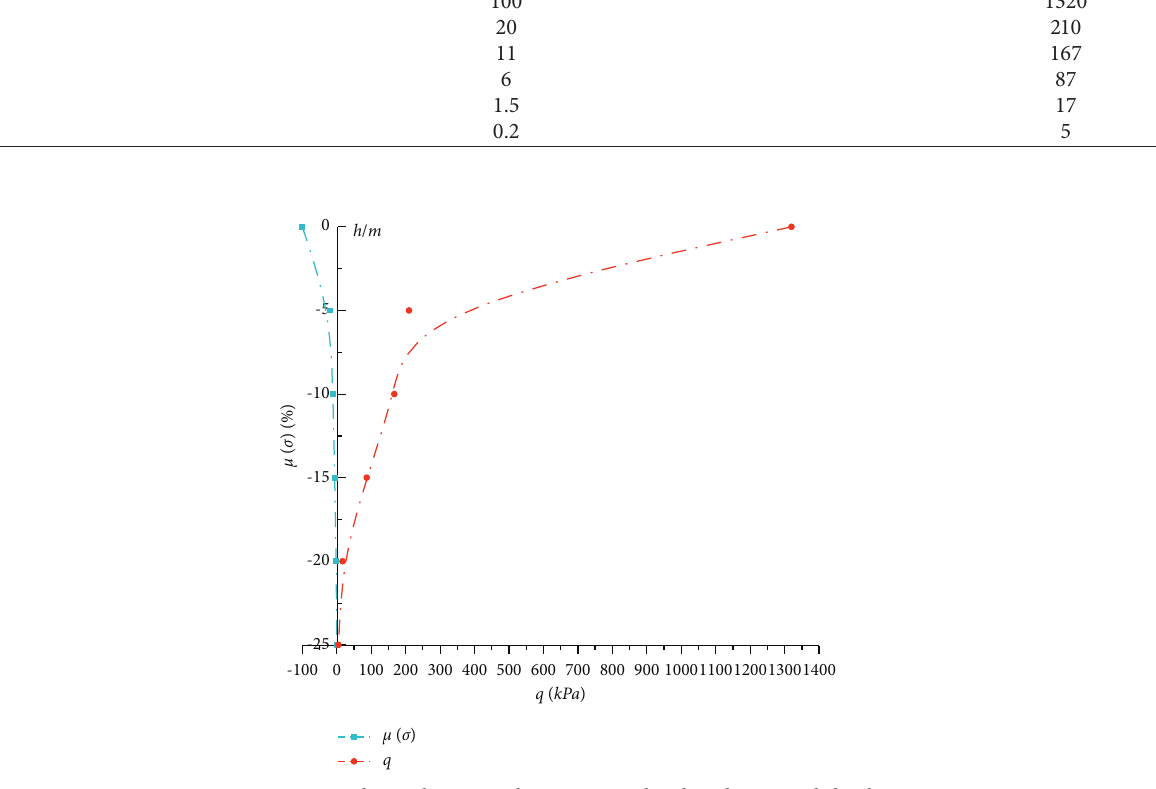
Figure 18: Relationship curve between membership degree and depth.